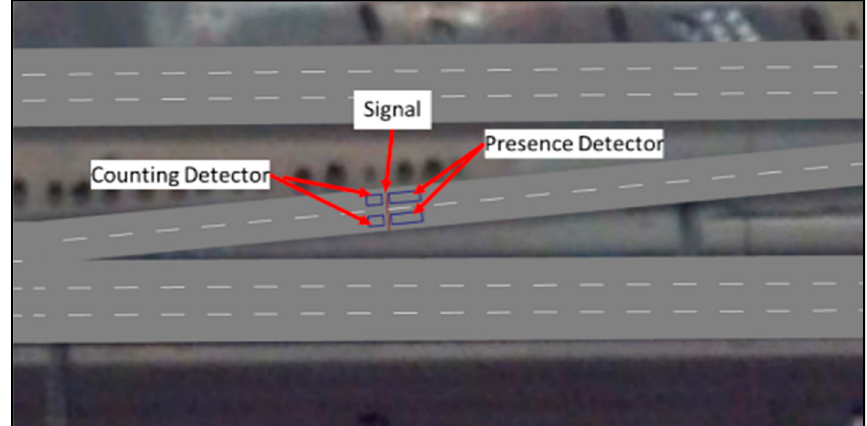
Figure 4. The layout of the fixed RM scenario. Table 3. Preparation of the sub-scenarios for the fixed time